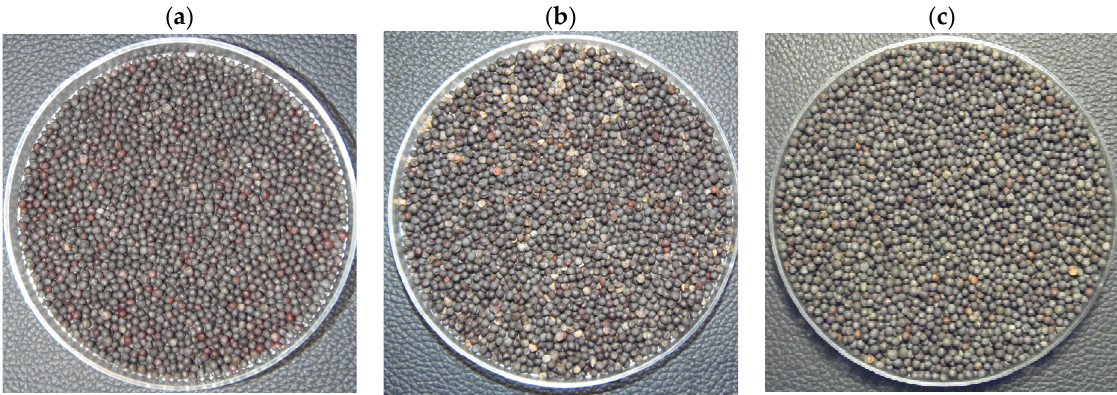
Figure 1. Seed samples of oilseed rapeseed varieties: ( a ) Atora F1, ( b ) Californium, ( c ) Graf F1.